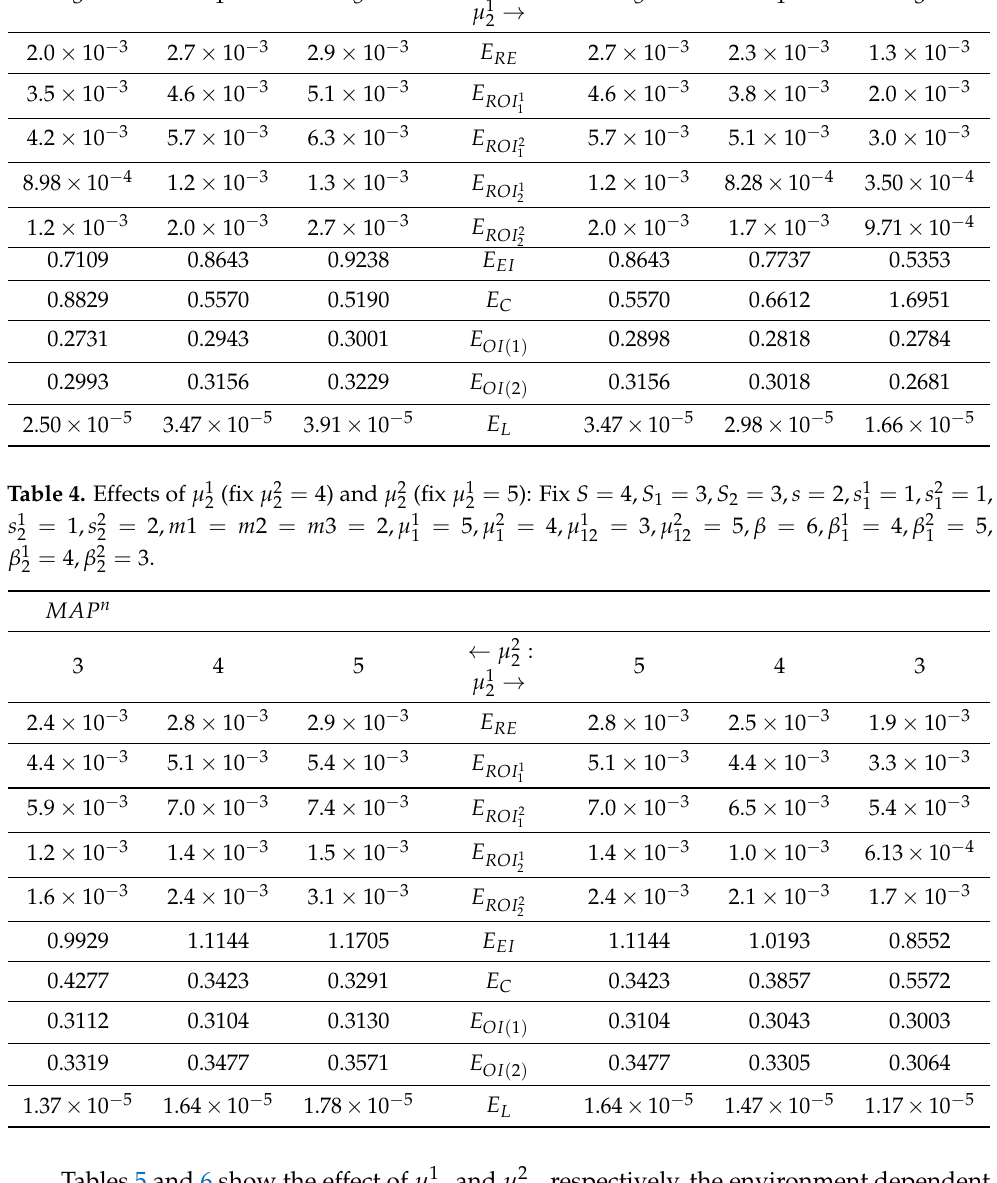
= 5): Fix S = 4, S (fix µ 1 2 2